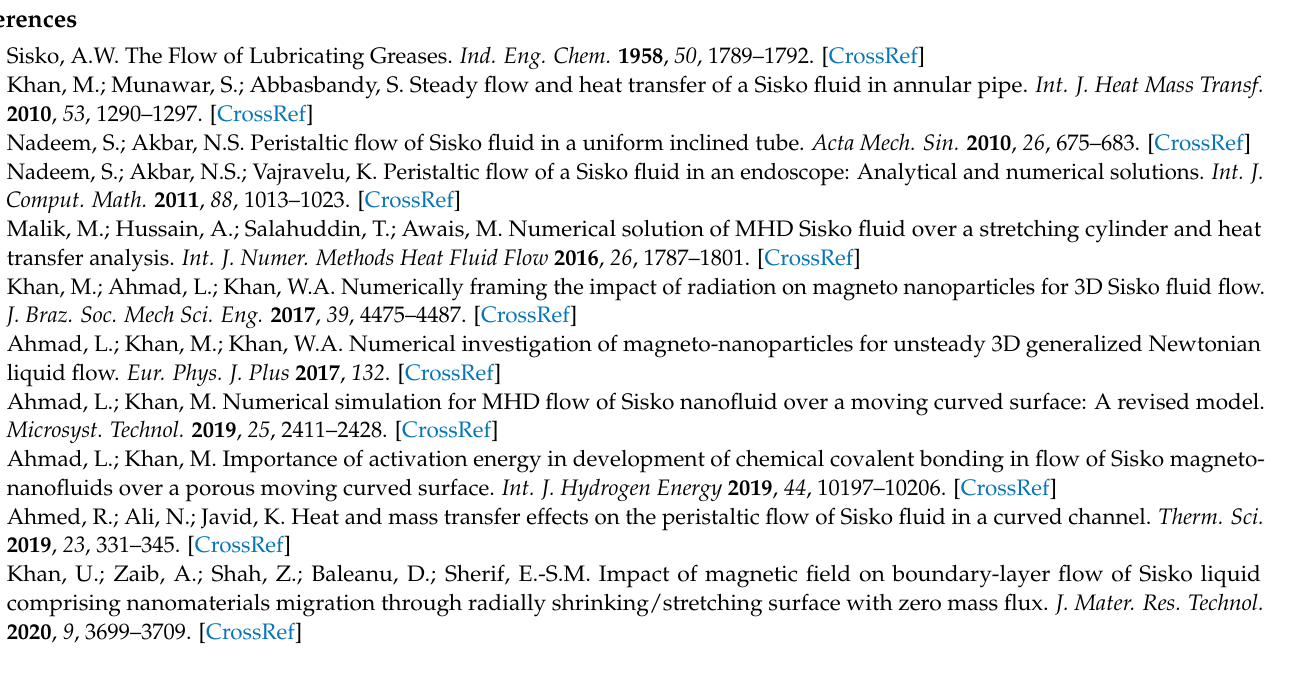
Table 2. Comparison of 1